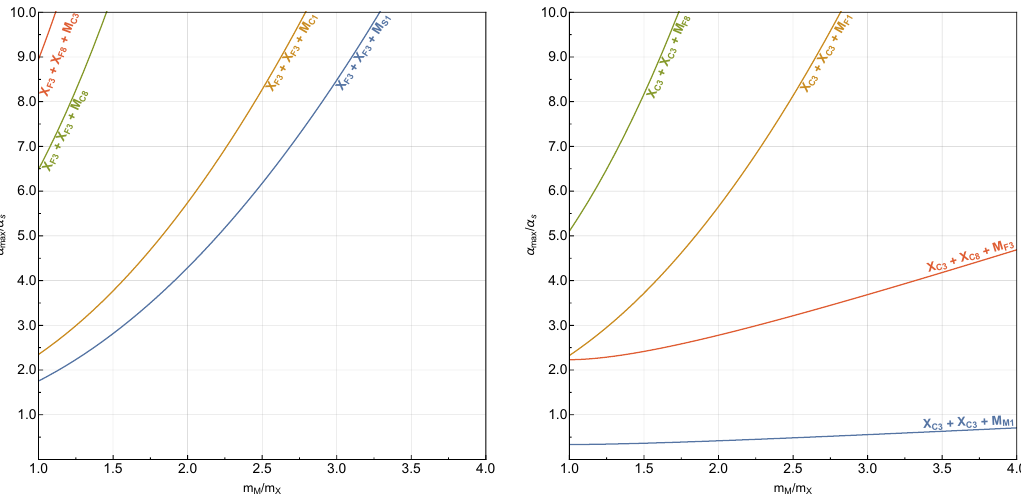
Figure 8 . ~ R = 1 contours for models where the mixed annihilation occurs via a t -channel mediator. The regions below the contours in the (cid:11) max versus m M =m X plane satisfy the mixed condition